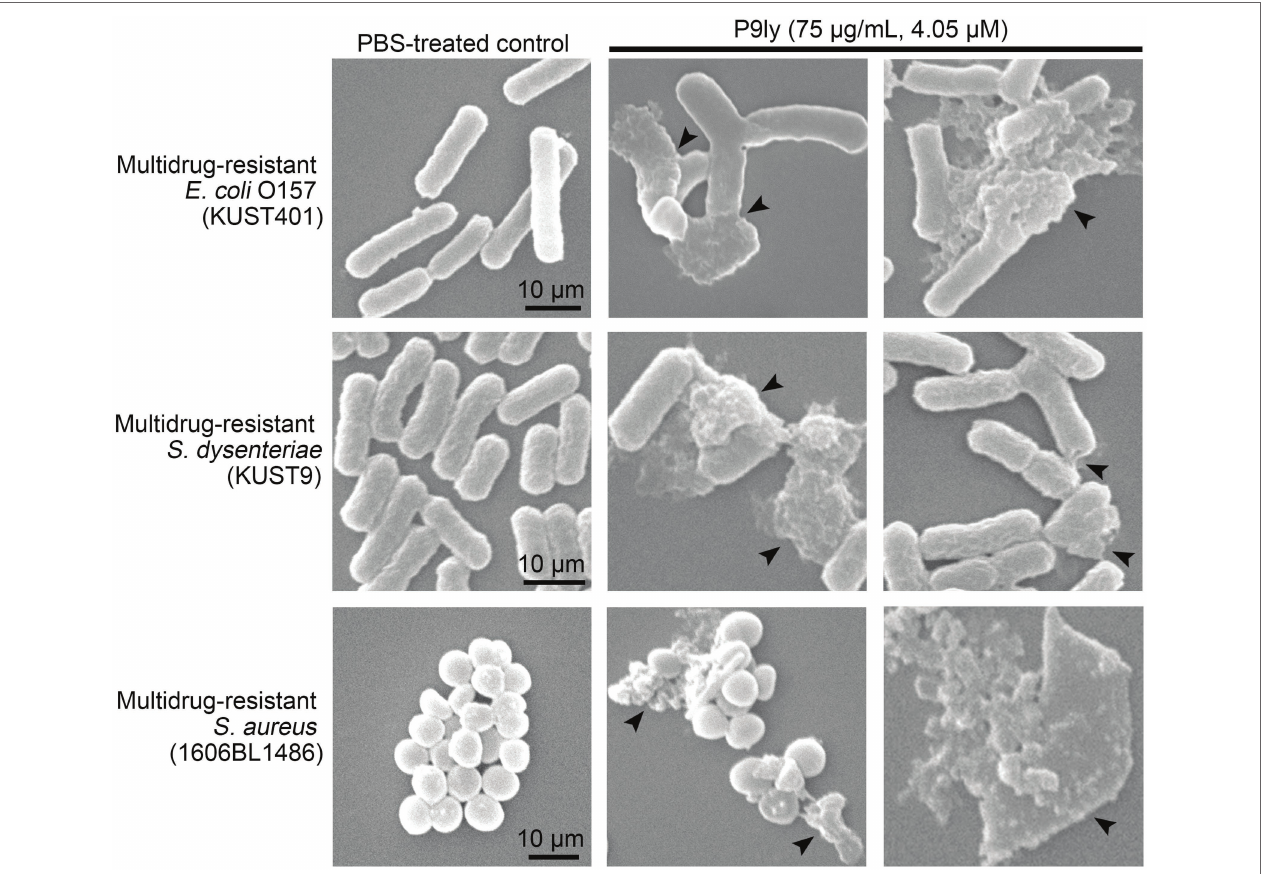
FIGURE 8 | Scanning electron microscopy was used to observe lysis in multidrug-resistant Gram-negative bacteria ( Escherichia coli O157 and Shigella dysenteriae KUST9) and Gram-positive bacteria ( Staphylococcus aureus 1606BL1486) after P9ly treatment. In all experiments, approximately 10 5 CFU/ml of different bacterial strains were incubated with 75 μ g/ml (4.05 μ M) P9ly or PBS control at 37 ° C for 60 min. In the figure, black arrows indicate the bacteriolytic effects of P9ly on bacterial cells. The scale bar for each bacterial strain is 10 μ